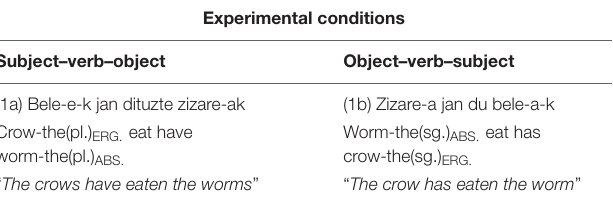
TABLE 3 | Example of experimental